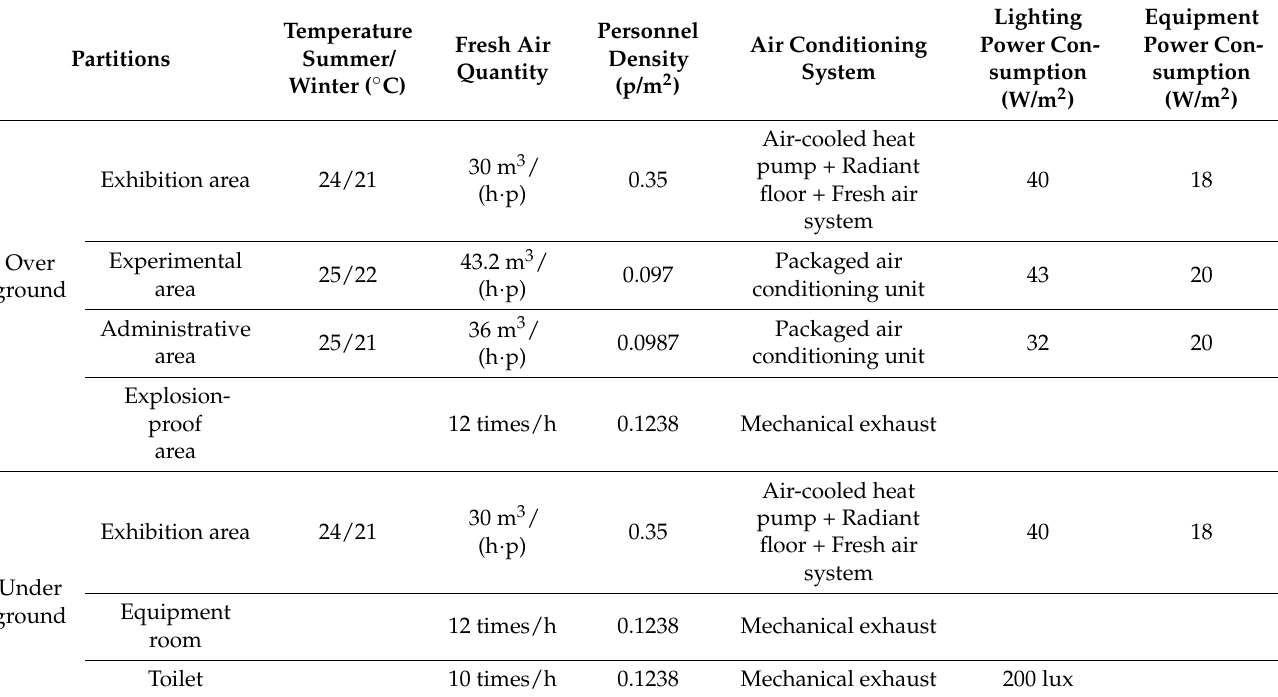
Table 6. Parameters of air conditioning system and other